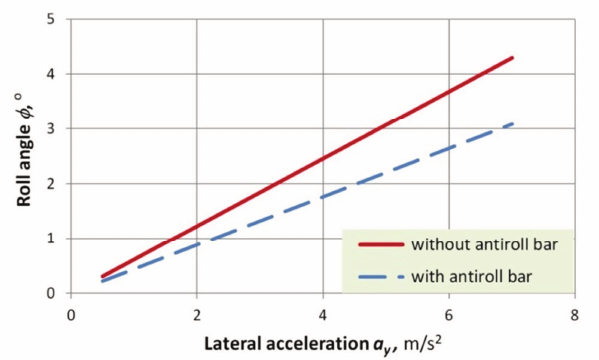
Fig. 6. The impact of lateral acceleration on the vehicle roll angle (for a full-size vehicle) [own research]